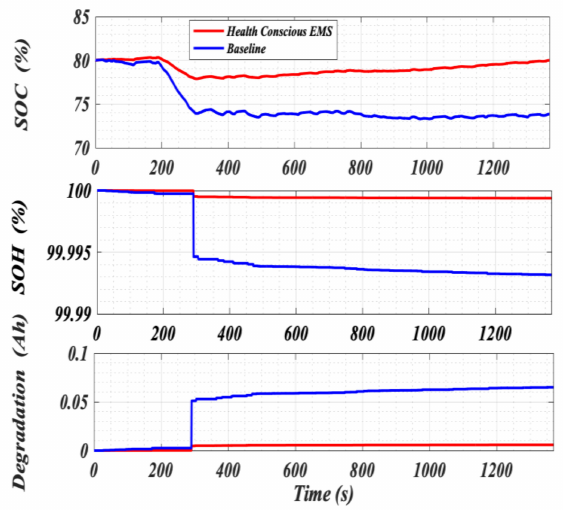
Figure 7. Battery SOC, SOH, and degradation for the UDDS cycle.